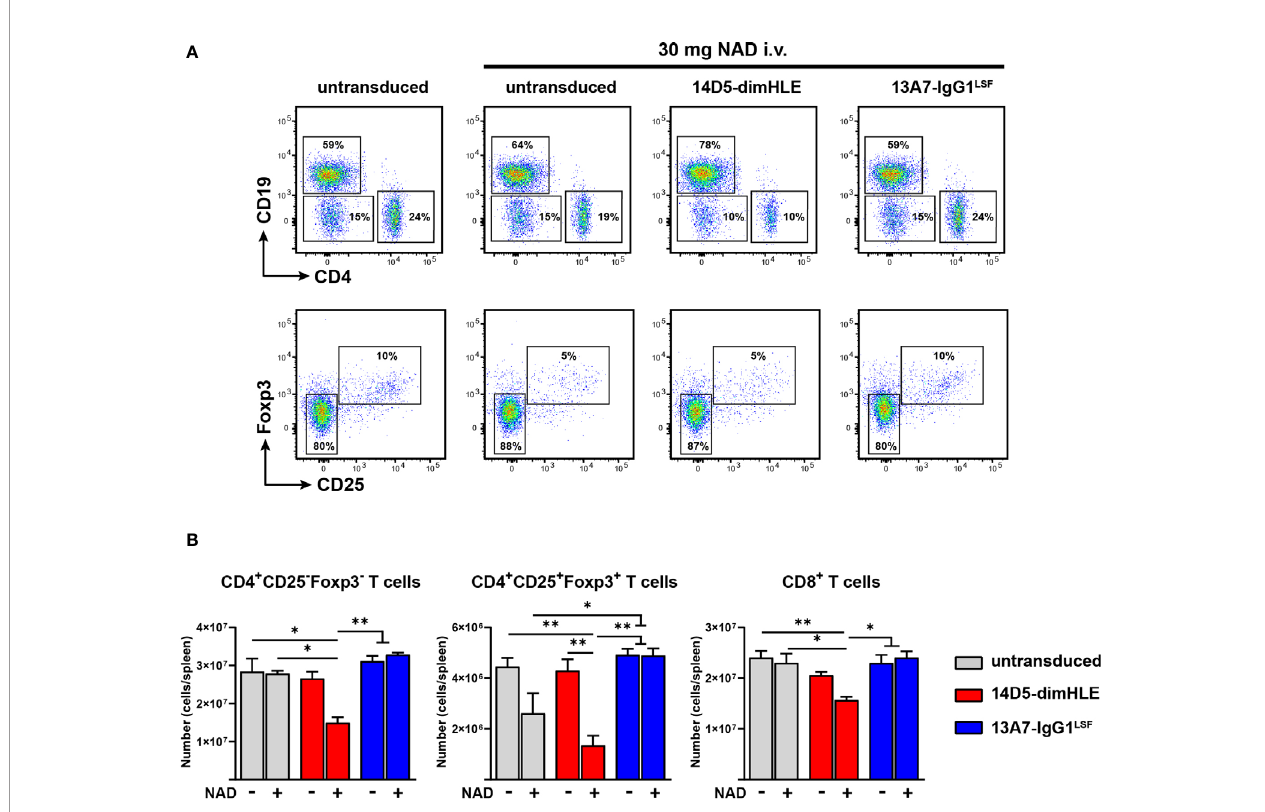
FIGURE 5 | AAVnano modulate in vivo the sensitivity to NAD + -induced cell death. C57BL/6 mice were injected i.m. with PBS (control) or with rAAV1 encoding the P2X7-potentiating 14D5-dimHLE construct or the P2X7-blocking 13A7-IgG1 LSF hcAb construct. 28 days later mice were injected i.v. with PBS or 30 mg NAD + . Splenocytes were collected one day after and analyzed by fl ow cytometry to evaluate the levels of P2X7-dependent T cell depletion induced by NAD + injection. (A) Representative fl ow cytometry plots showing the relative percentages of cells in each group. In the upper panels, CD4 + , CD8 + and CD19 + lymphocytes were concatenated in the same subpopulation and analyzed together to visualize the level of depletion of CD4 + and CD8 + (CD4 - /CD19 - ) T cells as compared to NAD + - insensitive CD19 + B cells. In the lower panels, the gated CD4 + cells were analyzed for both, expression of Foxp3 and CD25 to evaluate the percentages of Treg depletion in each group. Numbers indicate the percentage of cells in each indicated gate. (B) Absolute numbers of cells collected from spleen of untransduced control mice (grey) or from mice injected with rAAV encoding 14D5-dimHLE (red) or for 13A7-IgG1 LSF hcAb (blue). Each group was injected i.v. either with PBS (-) or with 30 mg of NAD + (+). Error bars represent the SEM. The statistical analysis was performed using one-way ANOVA (n=3 in each group, *p < 0.05, **p < 0.01). Staining was performed using fl uorochrome conjugated antibodies speci fi c to CD45 (coupled to BV510), CD4 (APC-Cy7), CD8 (BV605), CD19 (PerCP-Cy5.5), CD25 (PE) and FoxP3